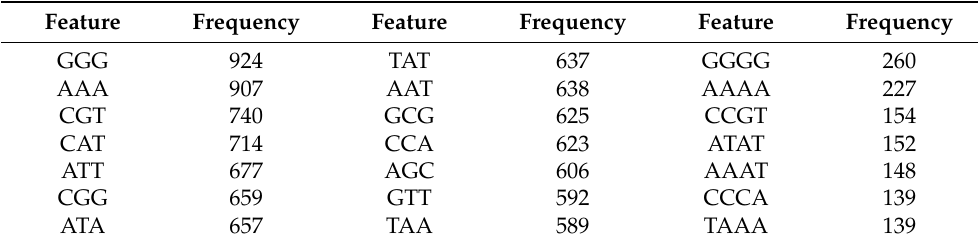
Table 9. The statistics of enhancer feature occurrence frequency in IMR90.